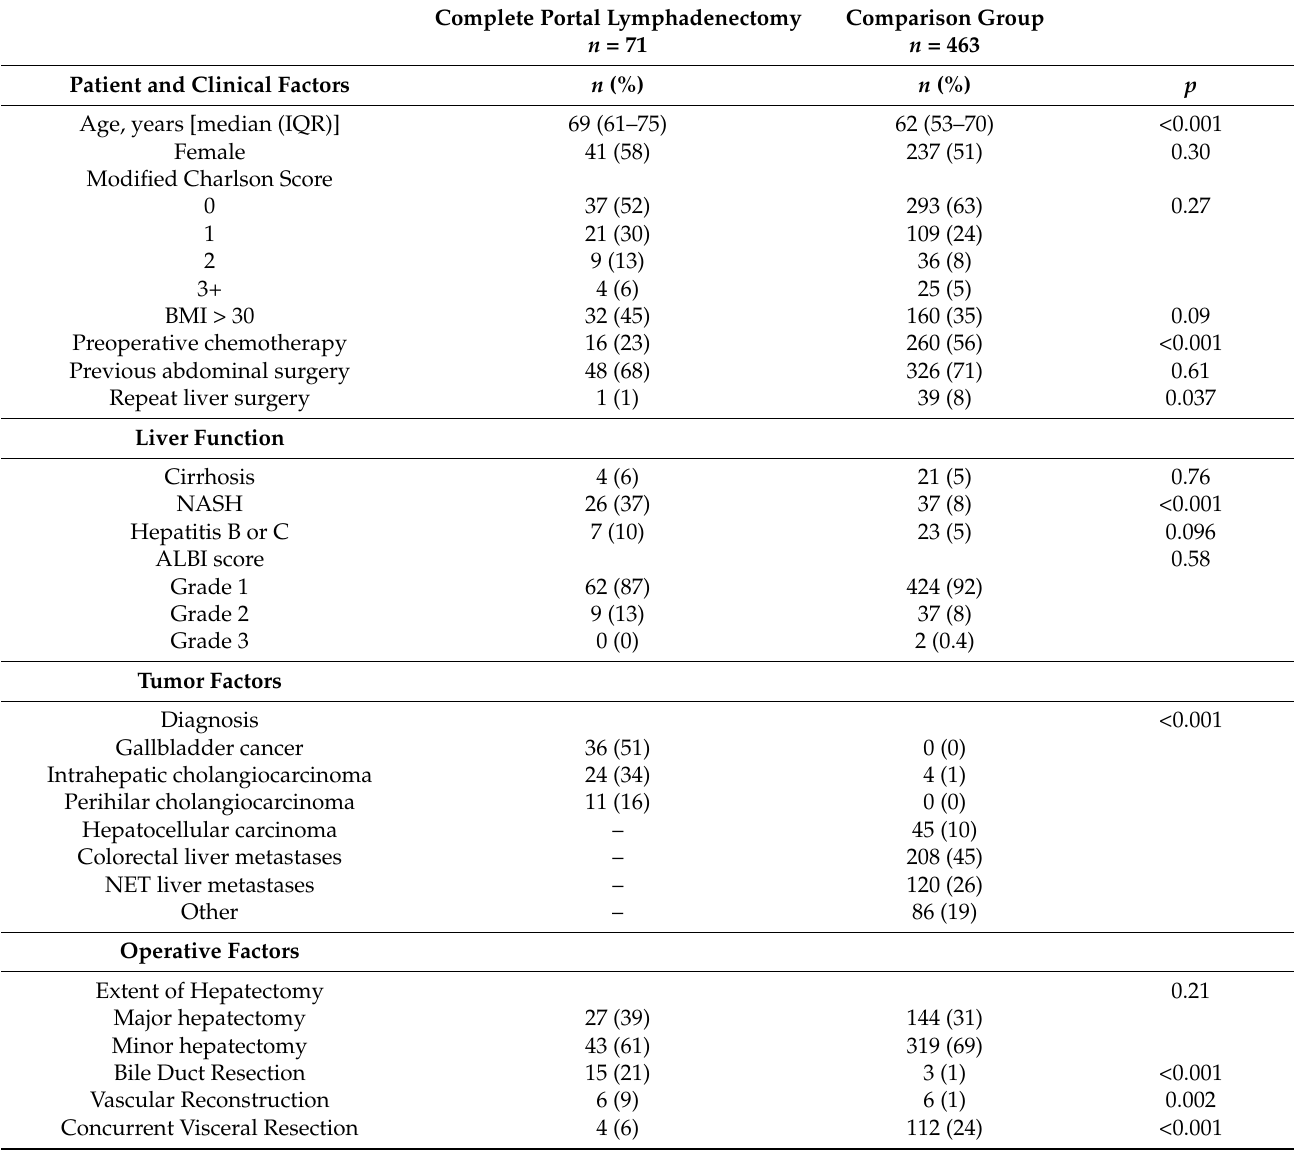
Table 1. Characteristics of Study Cohort. Complete Portal